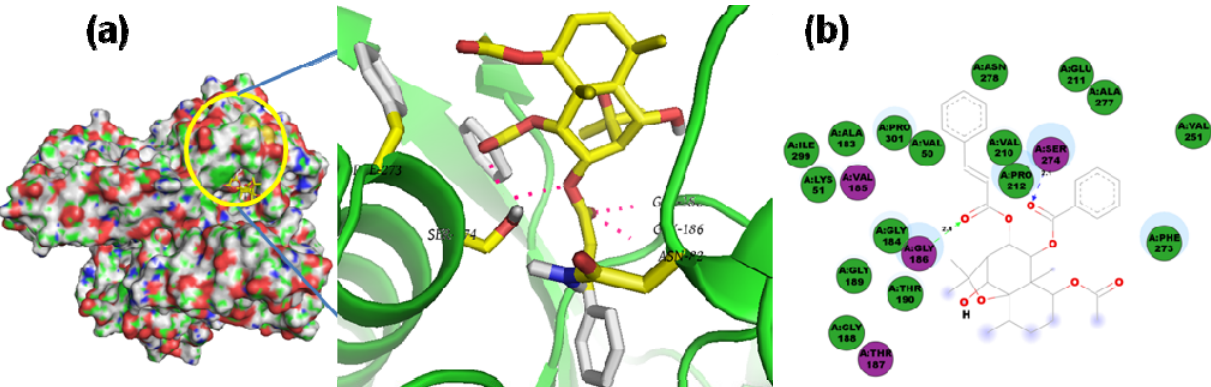
Figure 12. ( a ) Lowest-energy docked pose of agarofuran 30 with Lm CS; ( b ) 2D representation of protein ligand interactions of compound 30 with Lm